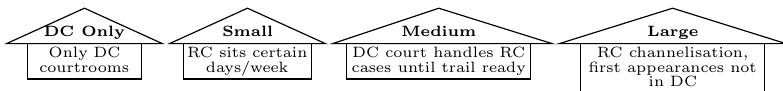
Figure 4: The set of court type simulation models used in the final model for lower